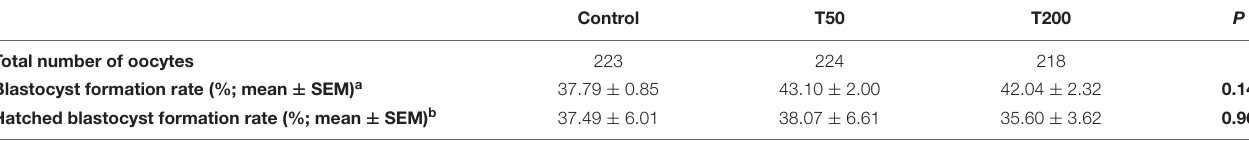
TABLE 2 | Embryo production in Control, T50, and T200 groups.